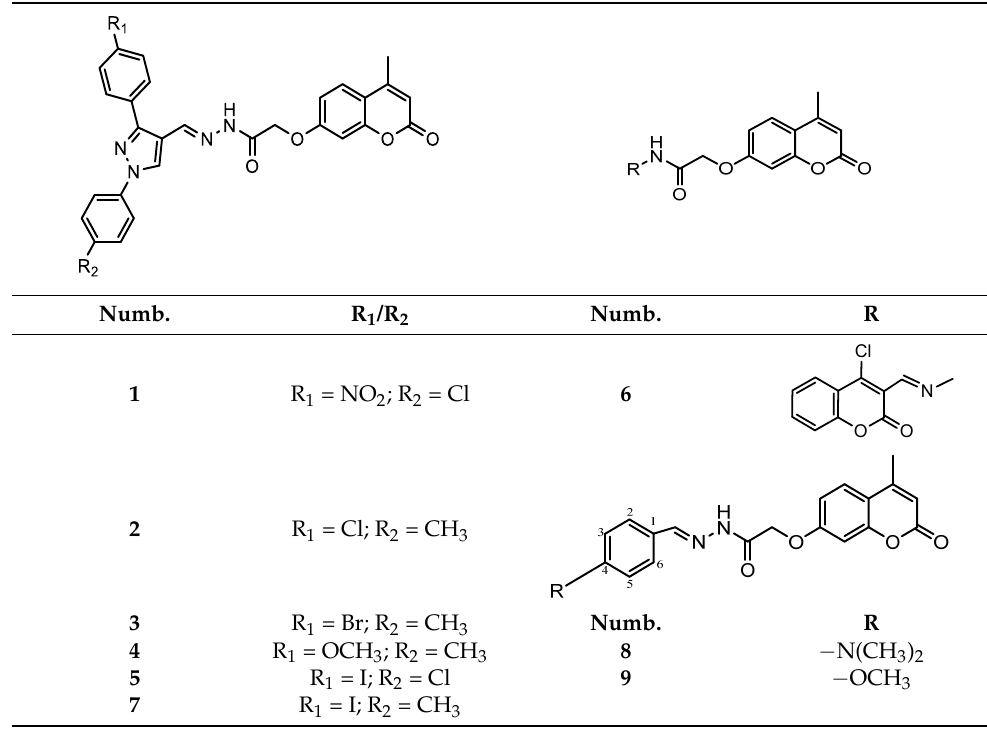
Table 1. Structures of the analyzed coumarinyl Schiff bases.